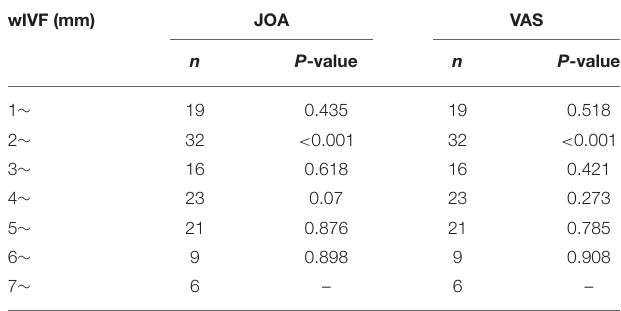
TABLE 3 | The differences of JOA and VAS score between each wIVF subgroup of ACDF alone patients.